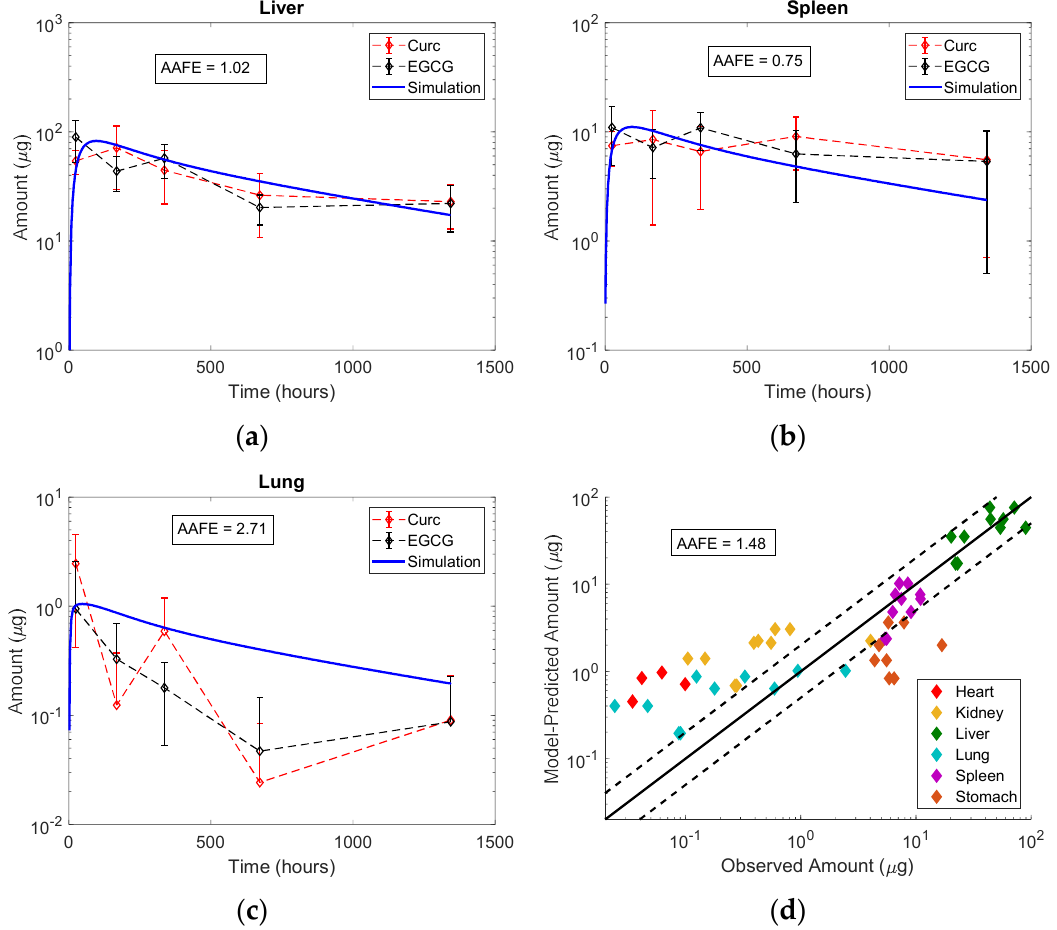
Figure 7. Final mouse model simulations compared to the observed biodistribution data for organs in this study: ( a ) liver ( b ) spleen and ( c ) lung. ( d ) shows the model-predicted vs. observed amounts in each organ with relation to the equality line achieving an absolute average fold error of 1.48.